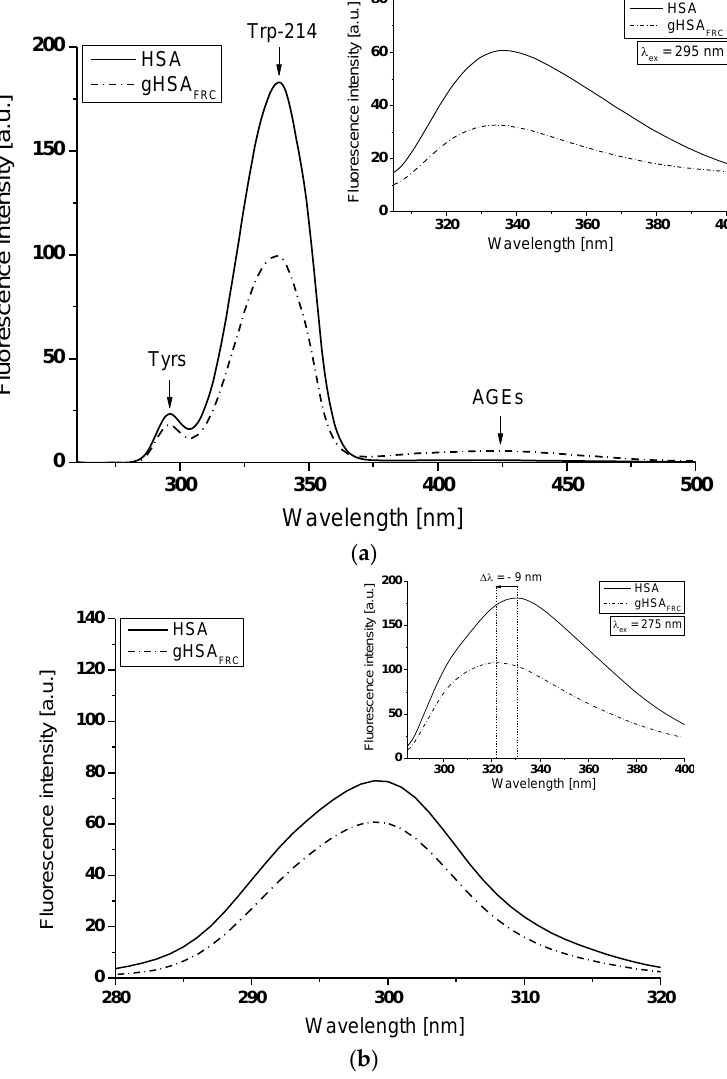
Figure 4. Main view: synchronous fluorescence spectra of non-glycated (HSA) and glycated (gHSA FRC ) human serum albumin at 5 × 10 −6 mol∙L −1 concentration ( a ) Δλ = 60 nm (λ ex = 220–440 nm), ( b ) Δλ = 15 nm (λ ex = 265–305 nm). Insert: comparison of HSA and gHSA FRC emission fluorescence spectra excited at ( a ) λ ex = 295 nm; ( b ) λ ex = 275 nm; t = 37 °C.